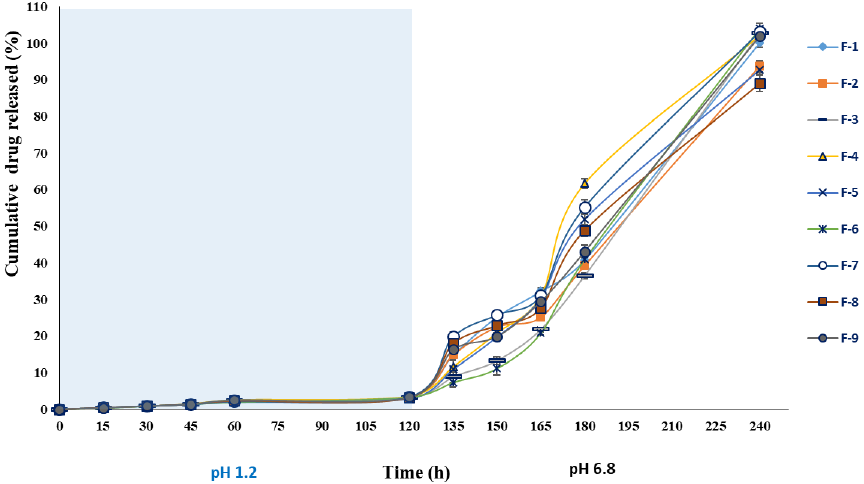
Figure 12. In vitro drug-release profile of alginate-BSO wet beads in simulated gastric fluid (pH 1.2) and simulated intestinal fluid (pH 6.8) (mean ± SD; n = 3).